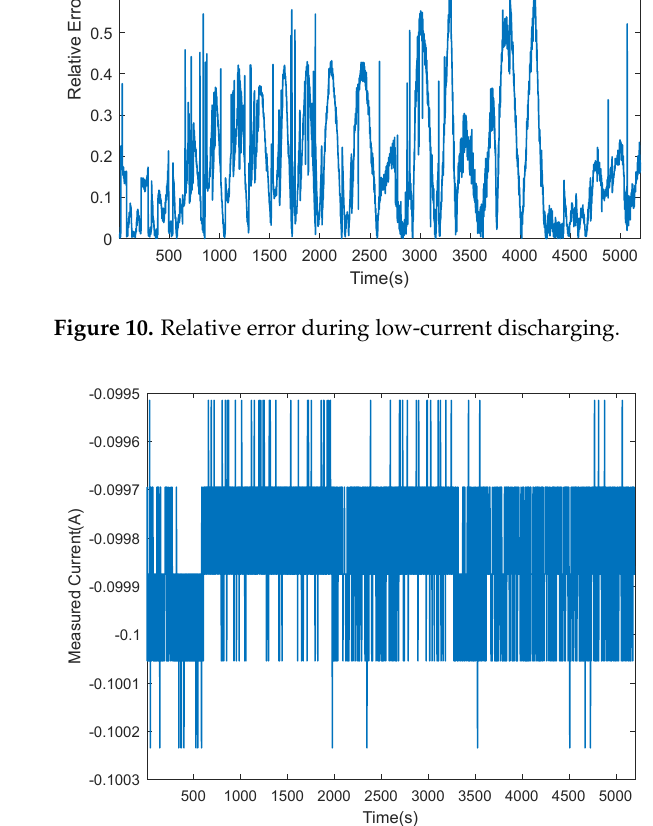
Figure 11. Measured current during low-current discharging.